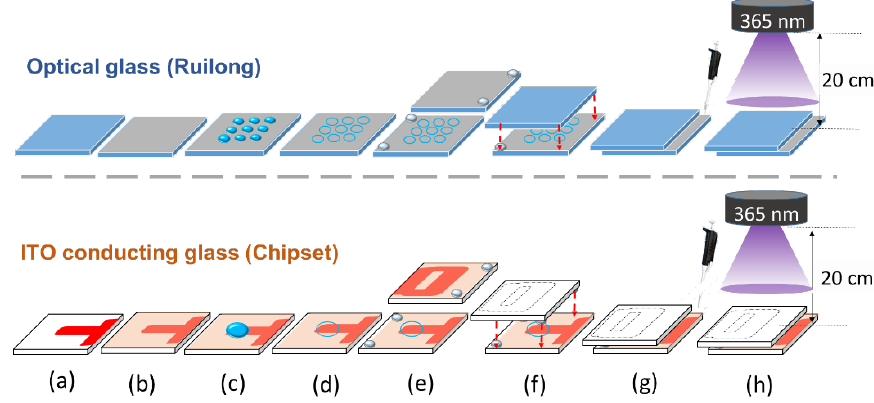
Figure 1. Procedures for establishing the biosensing platform based on the liquid crystal (LC)– photopolymer composite in which LC cells were assembled with either optical glass or indium– tin-oxide (ITO) conductive glass for optical or dielectric analysis, respectively. The glass substrates were cleaned to remove contaminants ( a ), followed by coating with dimethyloctadecyl[3-(trimethoxysilyl)propyl]ammonium chloride (DMOAP) as the vertical alignment layer ( b ) and immo- bilization with bovine serum albumin (BSA) ( c ). After drying at 35 °C on a hot plate ( d ), a mixture of 5.5 μm ball spacer and AB glue was applied at the corners of a pair of substrates ( e ) for the assembly of the LC cell ( f ). The NOA65/E7 mixture was then injected with a micropipette ( g ) and irradiated with UV light at irradiance of 5–20 mW/cm 2 ( h ).